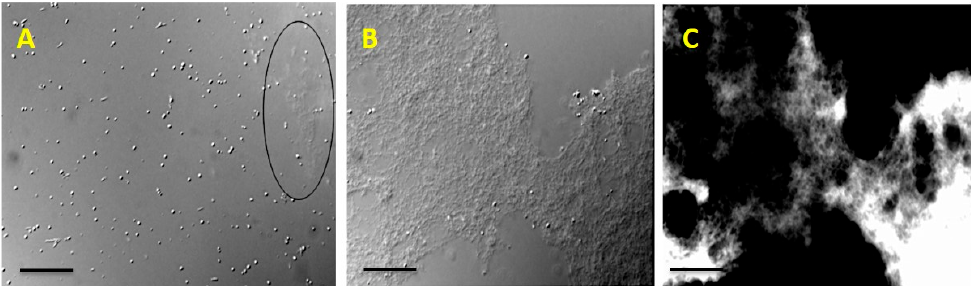
Figure 1. Detachment of EPS from the surface of R. tataouinensis TTB310 cells after suspending in modified PBS and 4% TCA treatment. ( A ) Optical microscopy image in which calcofluor white staining reveals a filamentous fluorescent part (cut-off area). ( B ) Optical microscopy image of a large fragment of EPS taken off. ( C ) The fluorescence image after staining with calcofluor white corresponding to image B, which shows the fluorescence of the peeled polymer. Scale bar: 20 μ m.